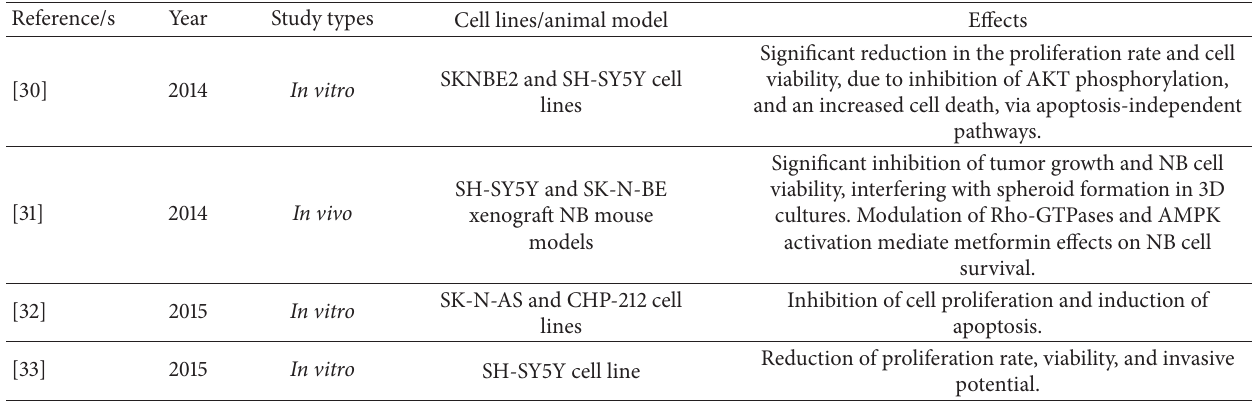
Table 2: Studies on metformin treatment to date in